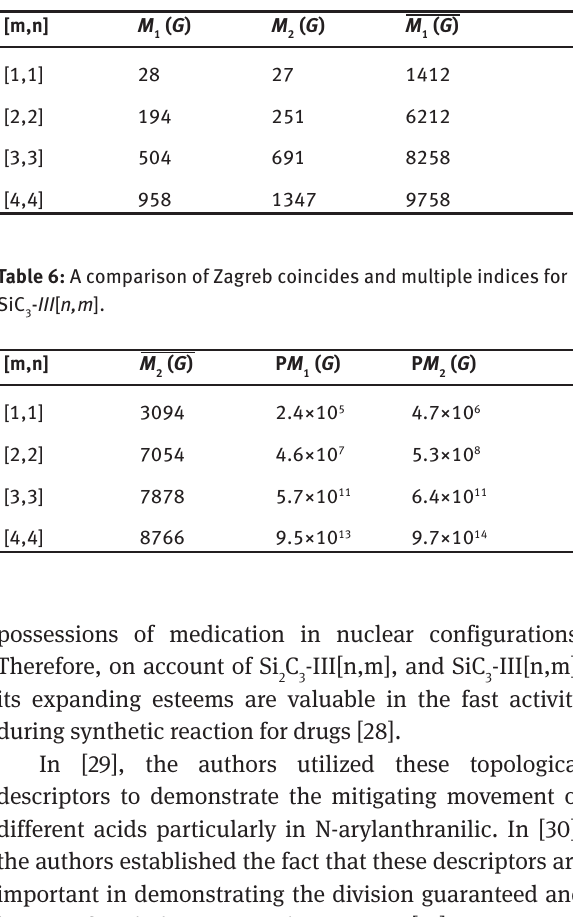
Table 5: A comparison of Zagreb indices and coincides for SiC - III [ n,m ]. 3